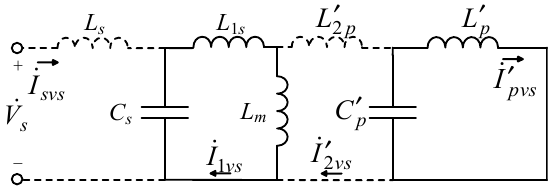
. V s V  only. Figure 7. Circuit state of a resonant network acted on by s